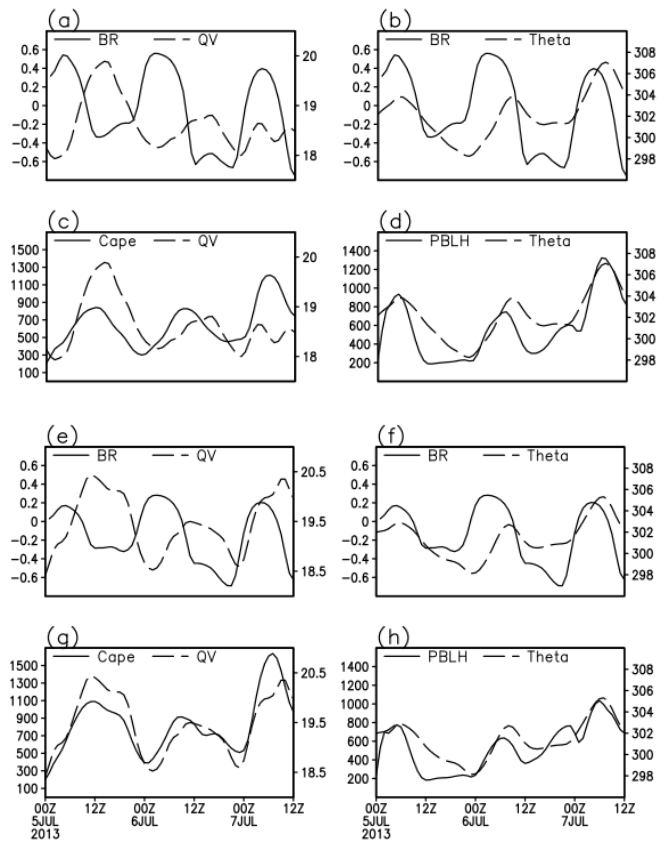
Figure 11. Time series of ( a ) Bowen Ratio (solid line, units: %) and 40-m water vapor mix ratio (dashed line, units: g ⋅ kg −1 ); ( b ) Bowen Ratio (solid line, units: %) and 40-m potential temperature (dashed line, units: K); ( c ) 500-m CAPE (solid line, units: J ⋅ kg −1 ) and 40-m water vapor mix ratio (dashed line, units: g ⋅ kg −1 ); and ( d ) PBL height (solid line, units: m) and 40-m potential temperature (dashed line, units: K) in DRY ensembles. ( e – h ) are the same as ( a – d ), but for the WP ensembles.